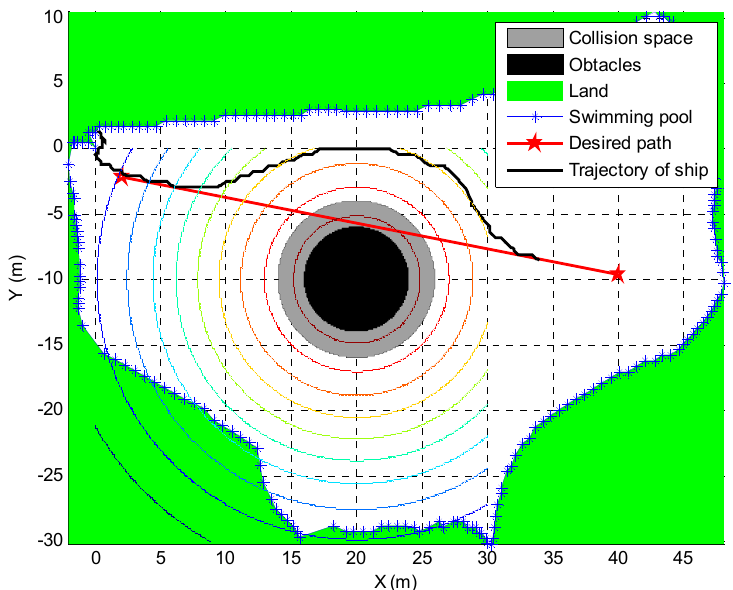
Figure 17. The path following and collision avoidance test using a free-running ship model.